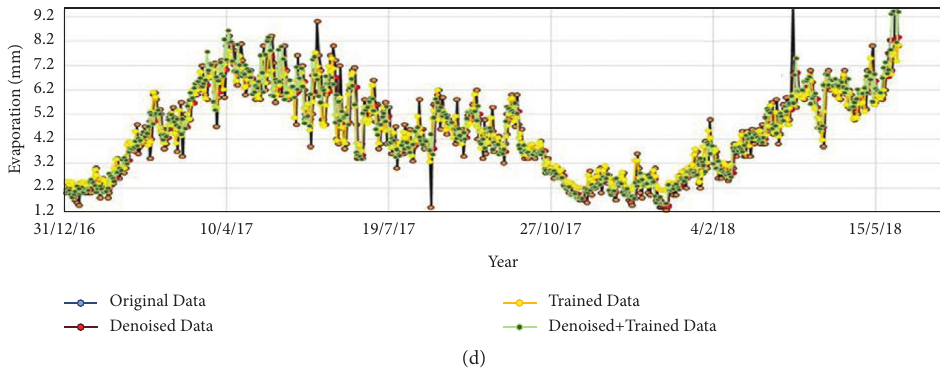
Figure 3: Original and denoised trained data time series for Delhi. (a) Maximum temperature data. (b) Minimum temperature data. (c) Wind speed data. (e) Evaporation